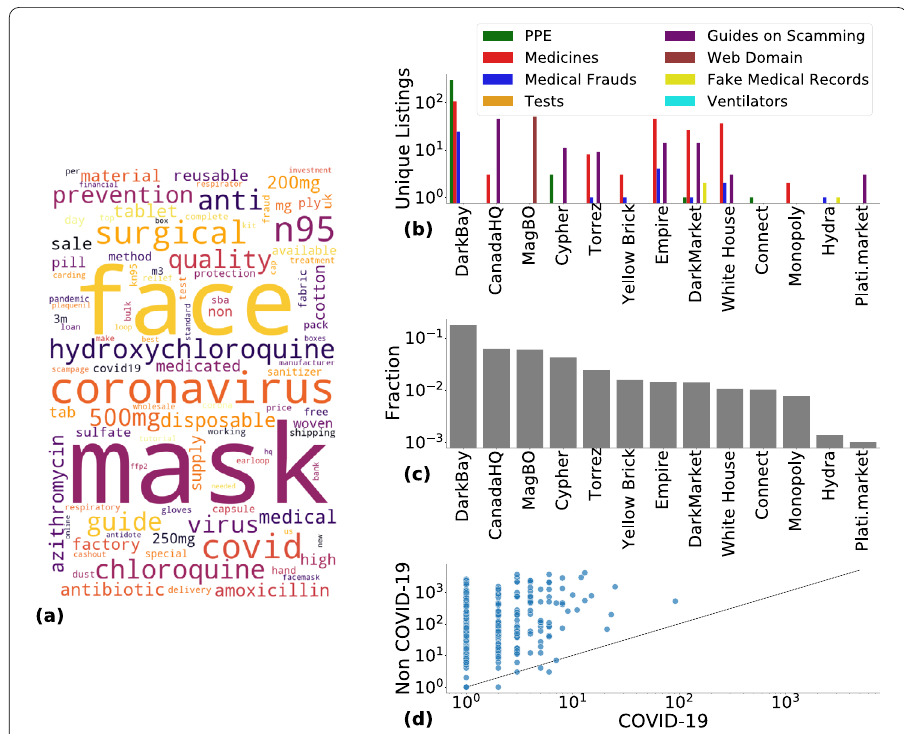
Figure 3 ( a ) Word cloud for “Listing title” in COVID-19 specific listings. ( b ) Category breakdown of COVID-19 specific listings in the DWM that offered them. ( c ) Fraction of vendors selling at least one COVID-19 specific listing. ( d ) Vendor specialisation. Most vendors responsible for at least one COVID-19 specific listing also sell other listings, and in greater number